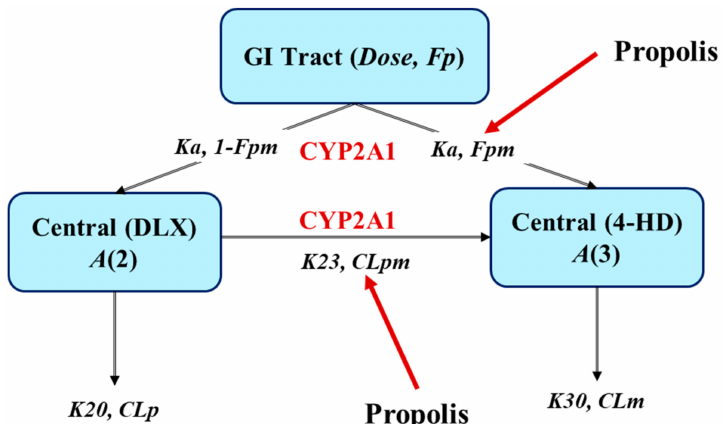
Figure 1. Schematic representation of the base population pharmacokinetic (PK) model for DLX and its metabolite, 4-HD, and strategies to investigate the e ff ect of PPL on the PKs of DLX after a single oral dose of 40 mg / kg DLX in rats. Notations are described in the main text. Pre-systemic ( F pm ) and systemic ( CL pm ) metabolisms.